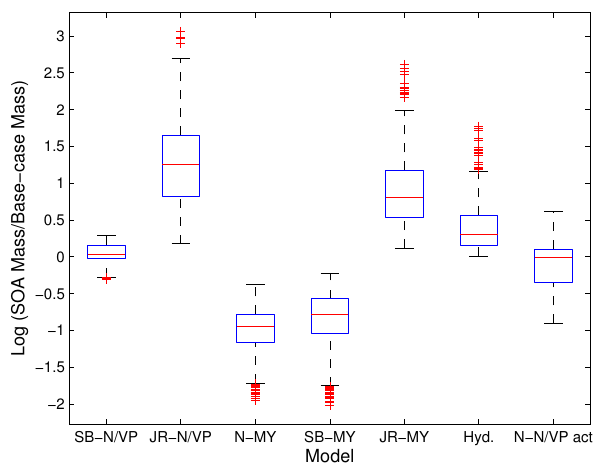
Fig. 2. Box-whisker plots showing the sensitivities of the predicted SOA mass, compared to the base case, across all cases for 27 sce- narios using the partitioning model with (a) five vapour pressure estimation methods (plots 1–5, 2742 compounds, γ i = 1); (b) plot 6 shows the effect of hydrolysis of acid anhydrides (2727 MCM com- pounds, p 0 by N-N/VP, γ i = 1); (c) plot 7 shows the sensitivity to non-ideality (2742 compounds, p 0 by N-N/VP, γ i by UNIFAC).